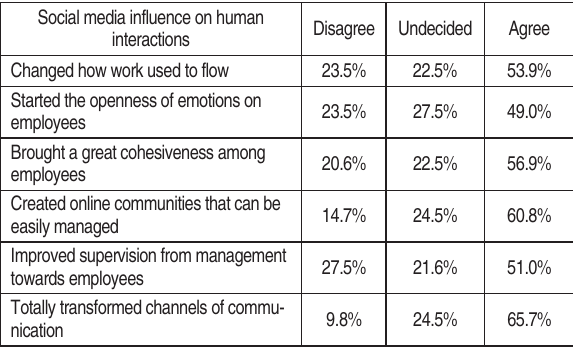
Table 4 reflects the influence of social media